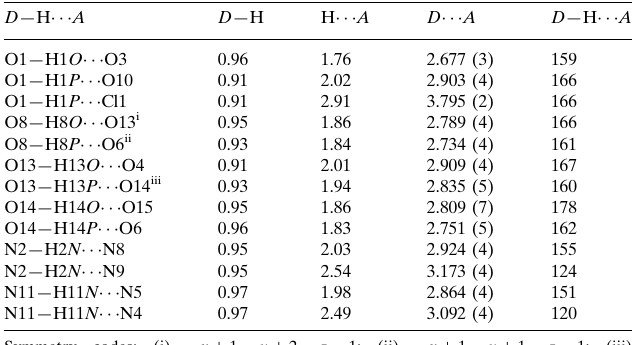
Data collection Nonius KappaCCD diffractometer Absorption correction: multi-scan ( SORTAV ; Blessing, 1995) T min = 0.866, T max = 0.959